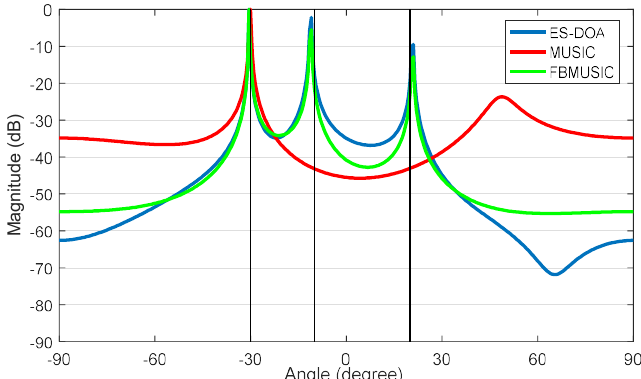
Figure 6. Azimuth spectrums of the various algorithms for coherent signals with 100 signal snapshots when SNR = 10 dB.